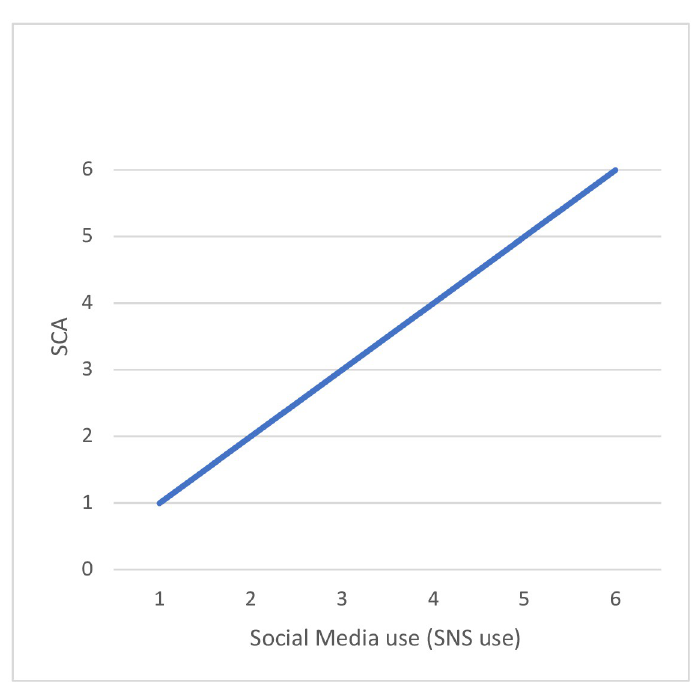
Fig 4. Self-centered appearance focused use of social media (SCA) correlation with social media use (SNS use).